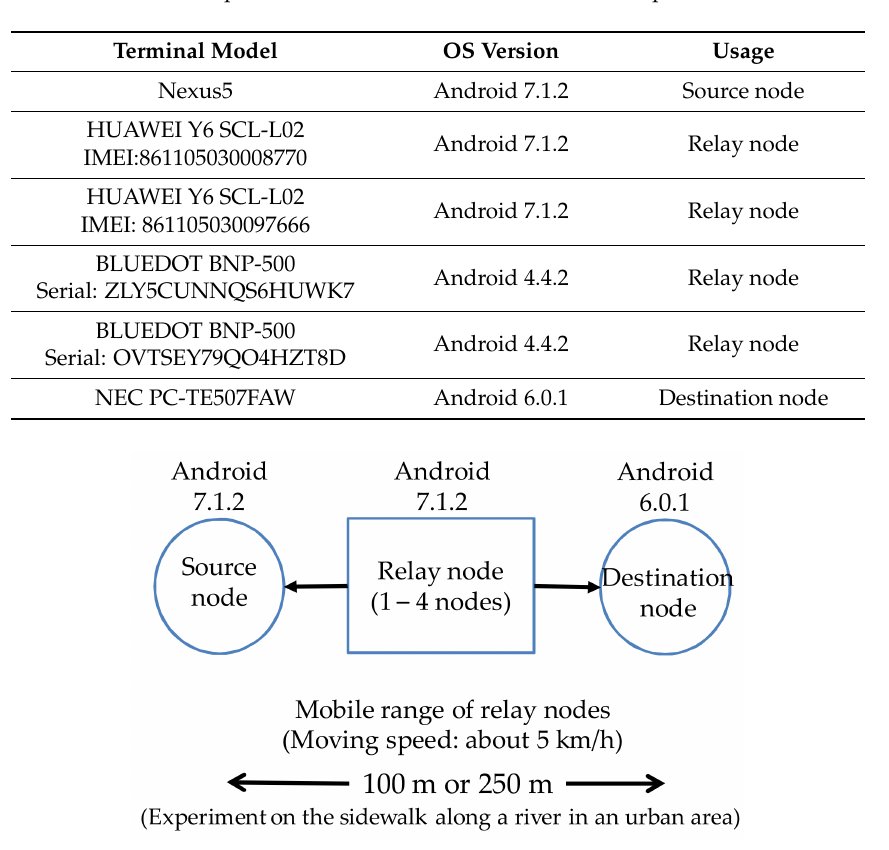
Figure 8. Structure of the experimental